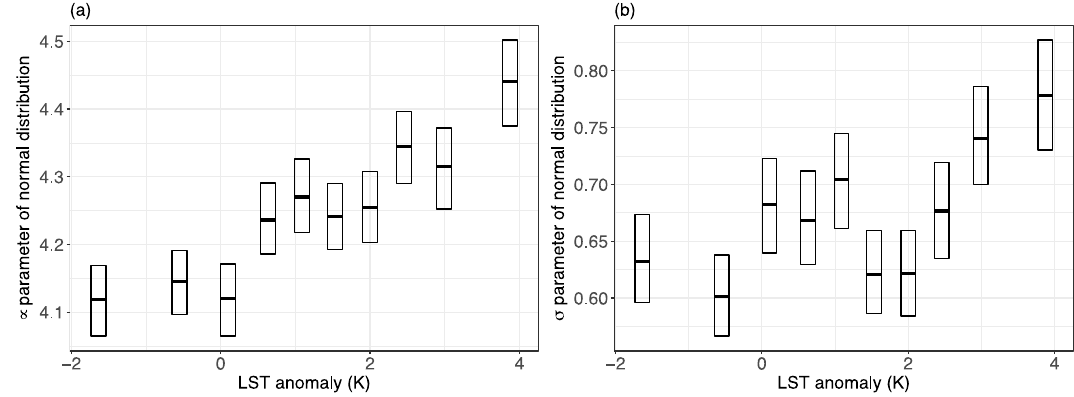
Figure 10. Plots of µ ( a ) and σ ( b ) parameters of normal distribution of log-transformed burned area and their 95% confidence intervals, conditional to land surface temperature anomaly in 10 decile bins.